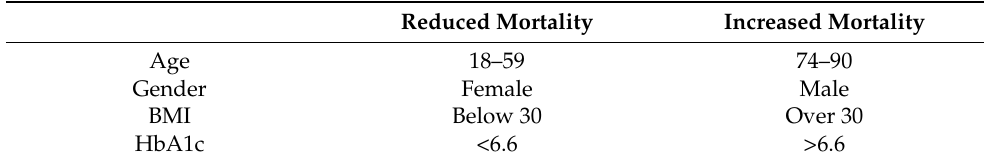
Table 3. Effects of specific values of the most predictive clinical variables on increasing or decreas- ing mortality.